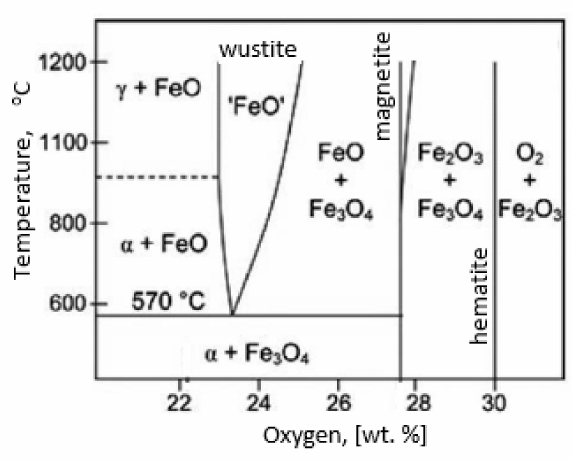
Figure 8. Iron / oxygen phase diagrams for the pressure of 1 atm—based on reference [30].